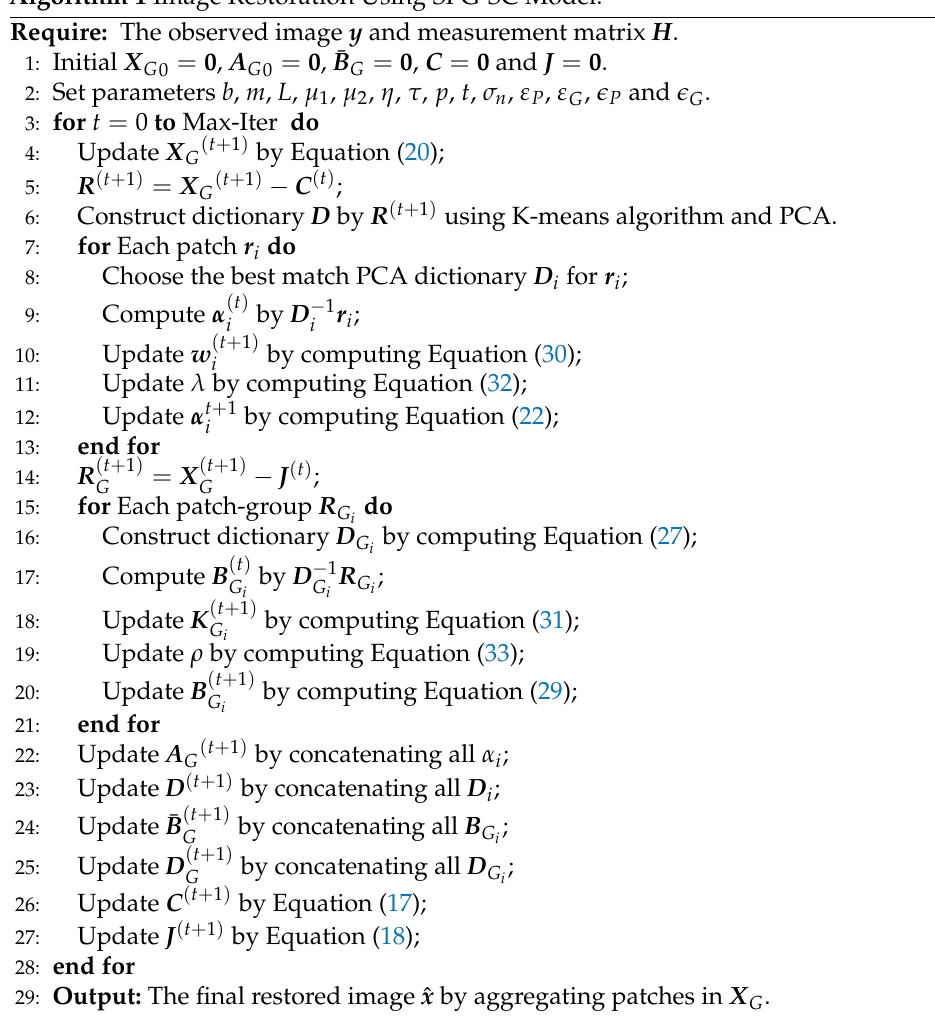
Algorithm 1 Image Restoration Using SPG-SC